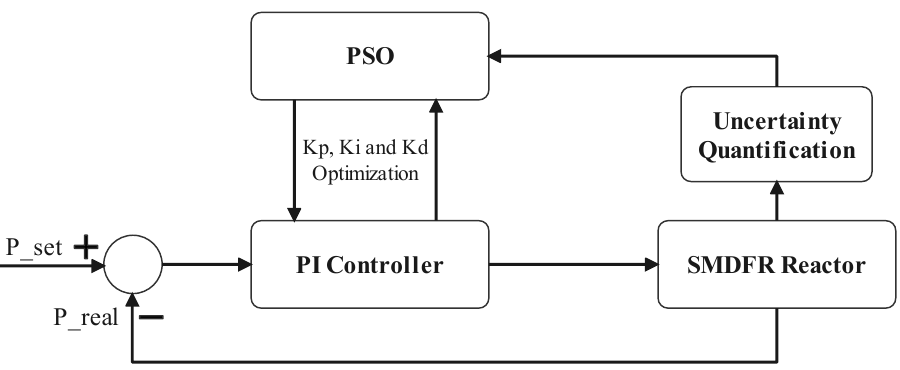
Figure 3. Structure of the uncertainty-based particle swarm optimization of the control